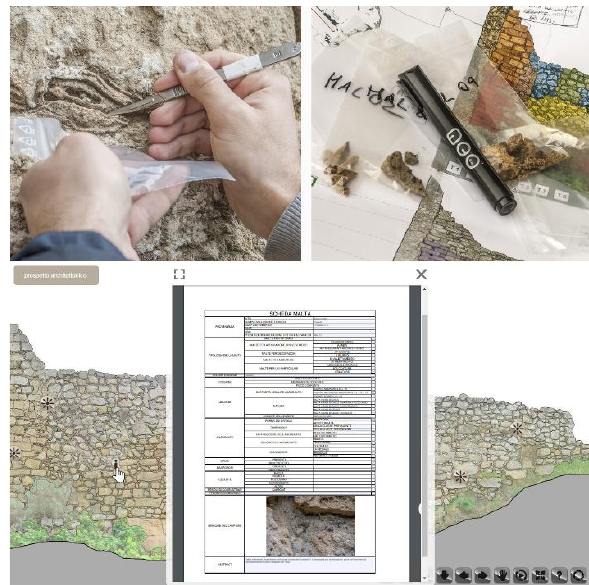
Figure 6. The mortars analysis undertaken in the castle of Assoro: collection, cataloguing and identification.